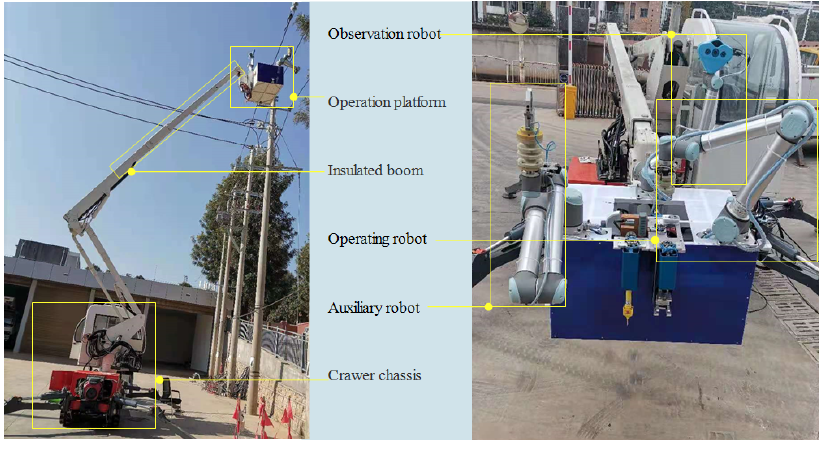
Figure 3. Autonomous live-line maintenance robot.